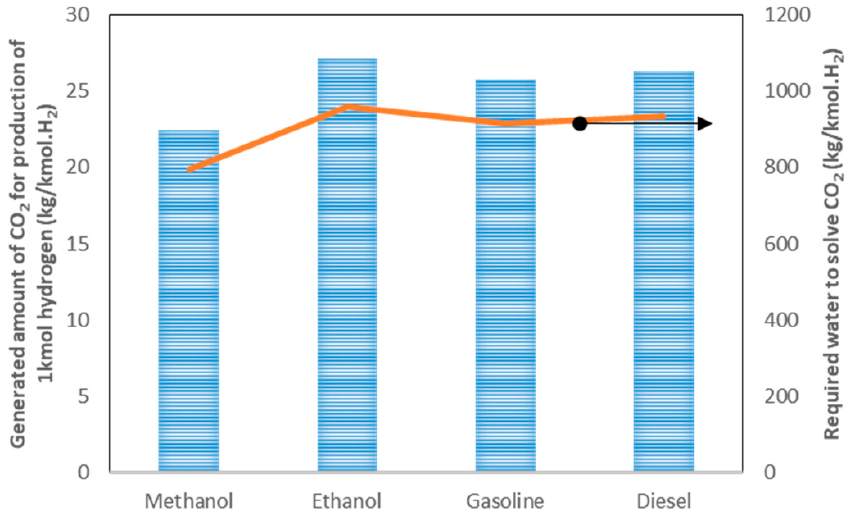
Figure 5. CO 2 to be generated and required water to solve CO 2 per produced H 2 (1 kmol) for diesel, gasoline, ethanol, and methanol.